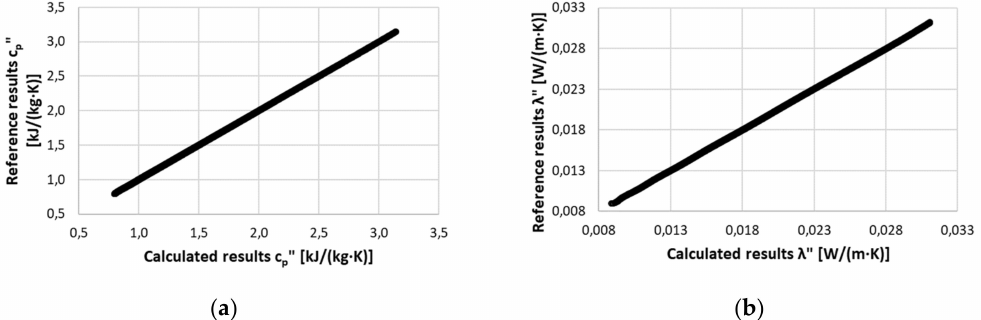
Figure 3. Comparison of the reference results and calculated results for saturated vapour: ( a ) Specific heat; ( b ) Heat transfer coe ffi